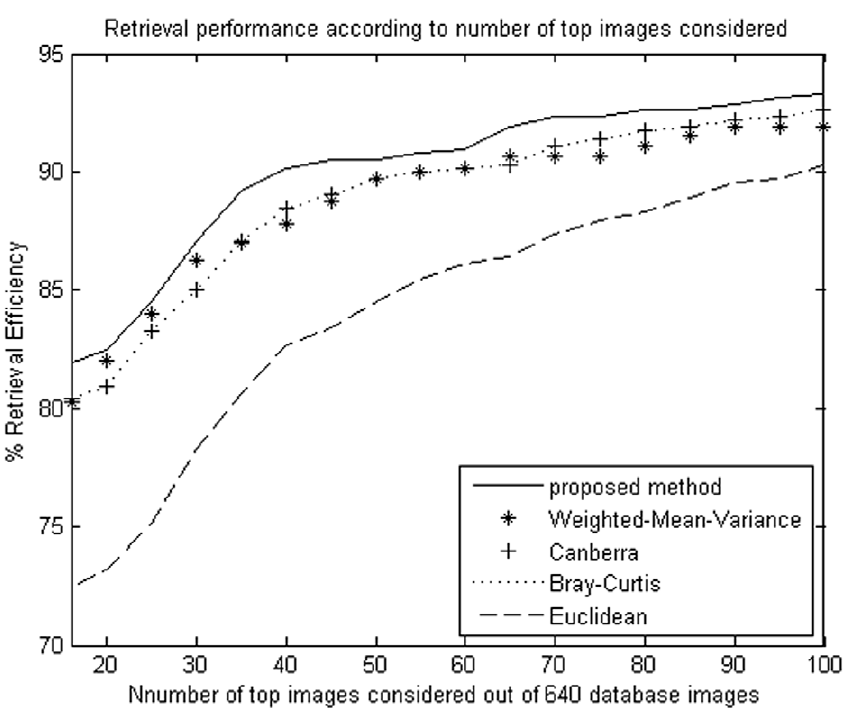
Figure 6. Average retrieval rate of database according to the number of top retrieved images using DT-CWT. The MIT image database (640 images) were used. doi:10.1371/journal.pone.0045302.g006 PLOS ONE |